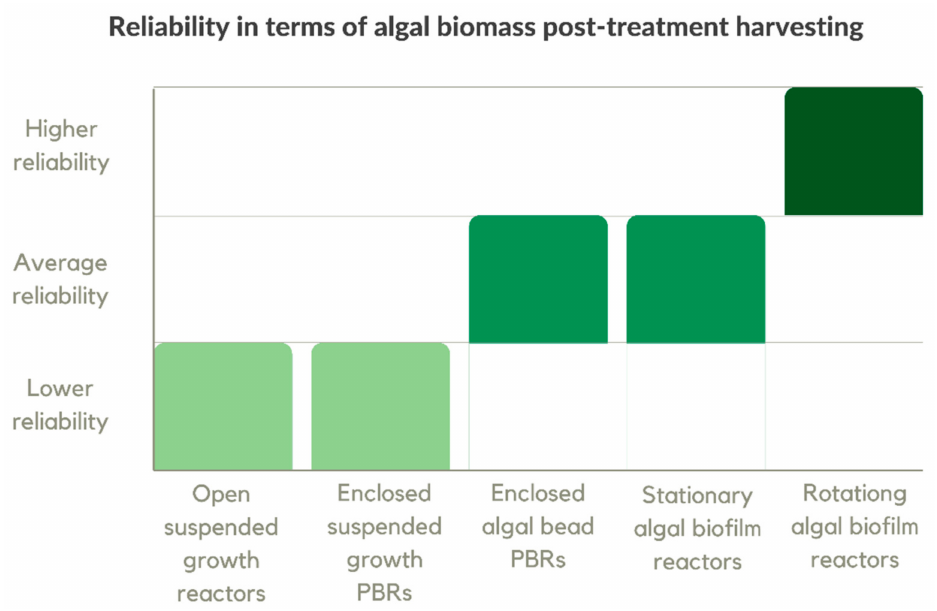
Figure 10. Reliability of the available algae-based wastewater treatment reactor configurations in terms of reliable algal biomass post-treatment